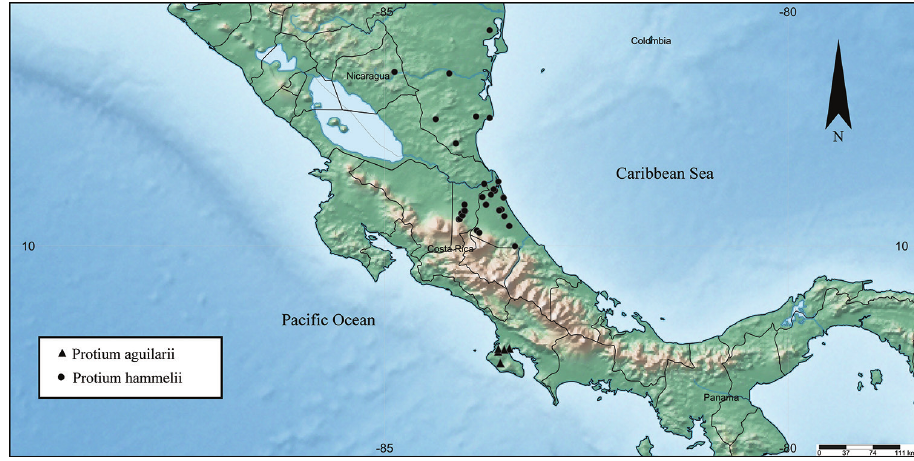
Figure 3. Distribution of Protium aguilarii and P. hammelii